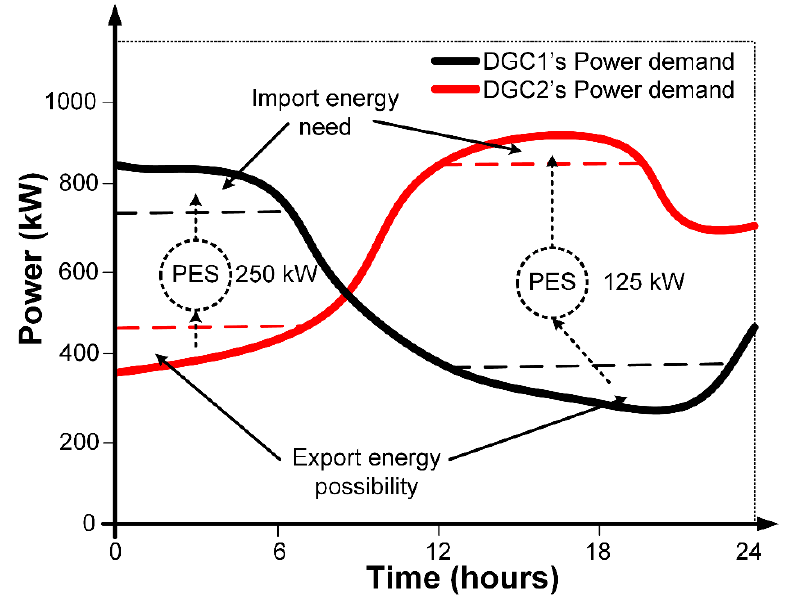
Figure 7. Emulation results for import and export energy process considering smooth filtering (curve smoothing) every 10 min.